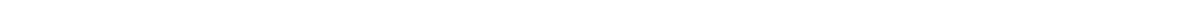
Fig. 4 Using spiking neural networks for pattern storage and replay: songbird singing. a A series of pulses constructed from the positive portion of a sinusoidal oscillator with a period of 20 ms are used to model the chain of fi ring output from RA projection neurons in HVC. These neurons connect to neurons in RA and trigger singing behavior. FORCE training was used to train a network of 1000 Izhikevich neurons to reproduce the spectrogram of a 5 s audio recording from an adult zebra fi nch. b The syllables in the song output for the teaching signal (top) and the network (bottom). c Spike raster plot for 30 neurons over 5 repetitions of the song. The spike raster plot is aligned with the syllables in b . d The distribution of instantaneous fi ring rates for the RA network post training. The α parameter corresponds to the up/down regulation factor of the excitatory synapses and to the different colors in the graphs of d , e . For α > 1, excitation dominates over inhibition while the reverse is true for α < 1. The inset of d , e is reproduced from ref. 37 . Note that the y -axis of the model and data differ, this is due to normalization of the density functions. e The log of the interspike interval histogram. f The correlation between the network output and the teaching signal as the excitatory synapses are upscaled (negative x -axis) or downscaled (positive x -axis). g The spectrogram for the teaching signal, and the network output under different scaling factors for the excitatory synaptic weights. The panels in g correspond to the plots in d